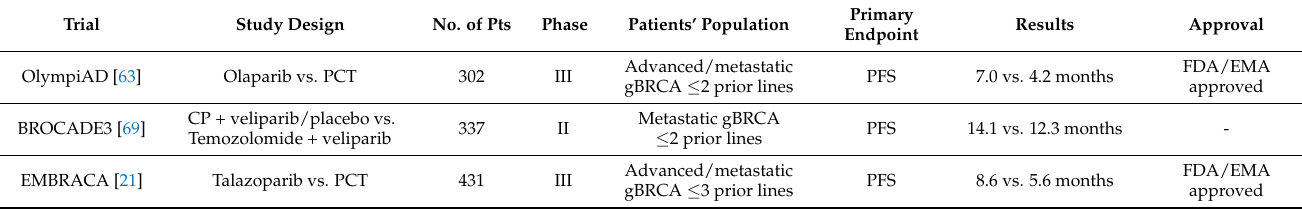
Table 1. Clinical trials with PARP inhibitors in the treatment of